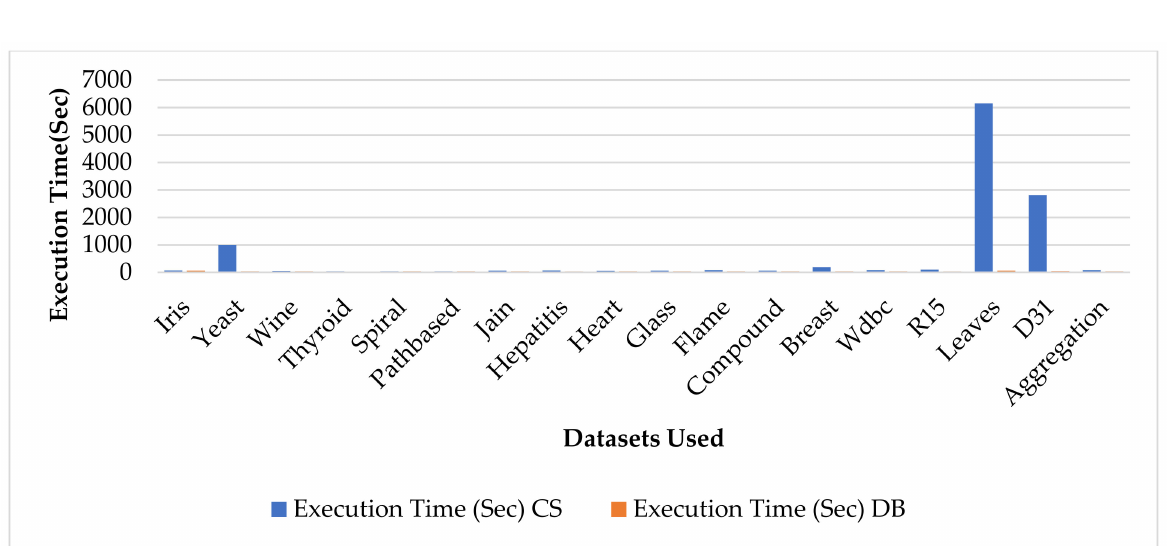
Figure 6. Average execution time taken by HCFAPSO on CS and DB indices for all the datasets used over 20 independent